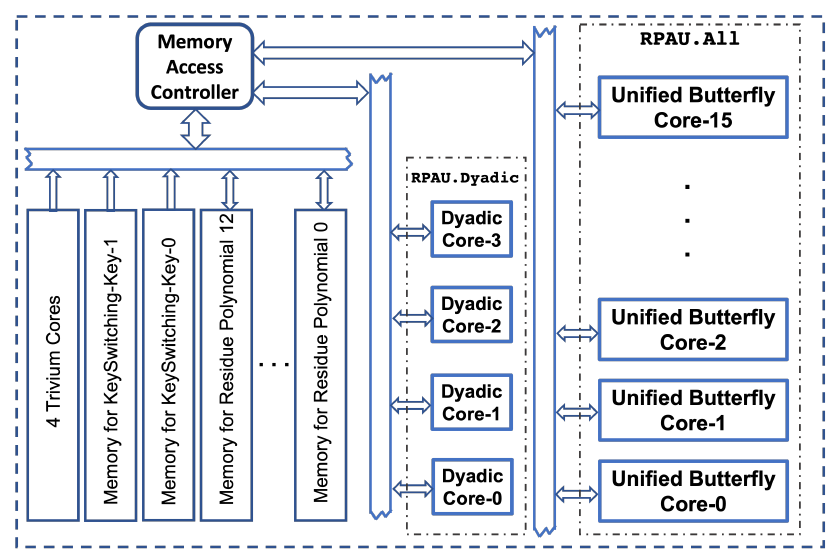
Figure 4: Architecture of the Residue Polynomial Arithmetic Unit